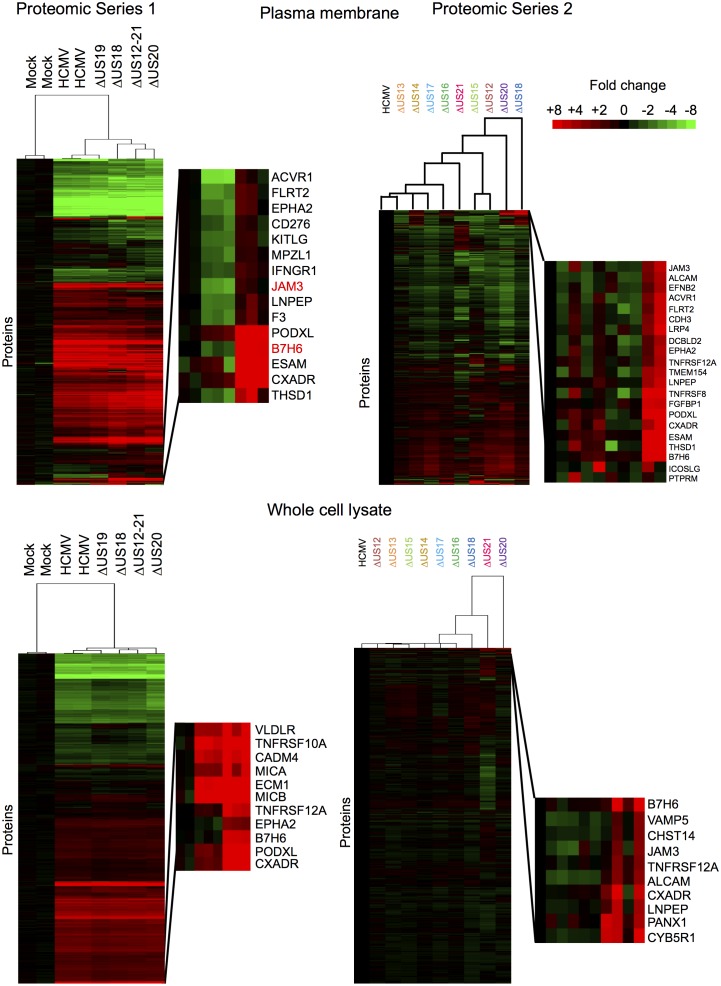
Hierarchical cluster analysis of all proteins quantified in proteomic series 1 and 2.Zoomed regions are shown for clusters of interest.